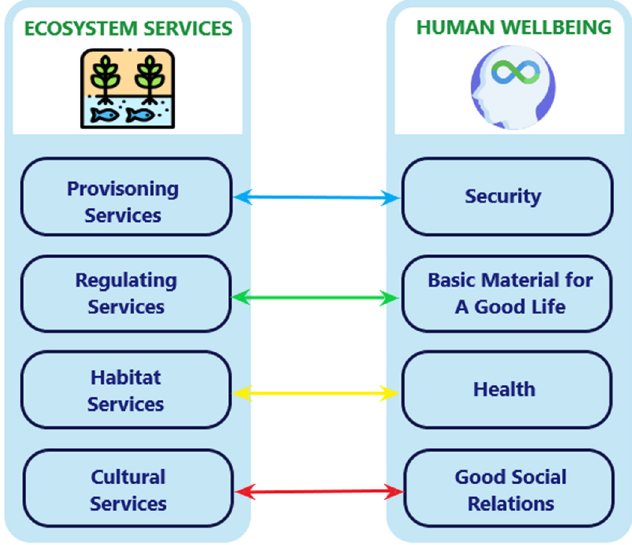
Figure 1. The corresponding domains between Ecosystem Services and Human Wellbeing (icons by Freepik from www.flaticon.com).